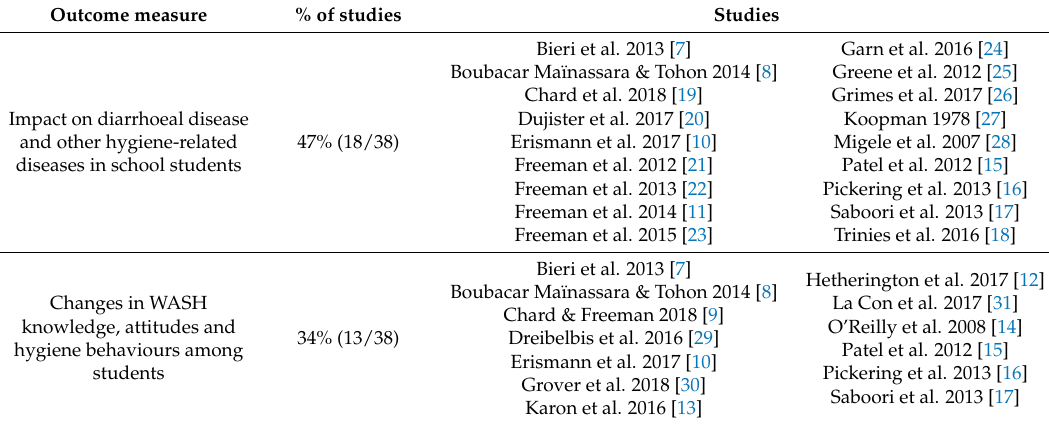
Table 1. Outcome measures reported in included articles ( n =